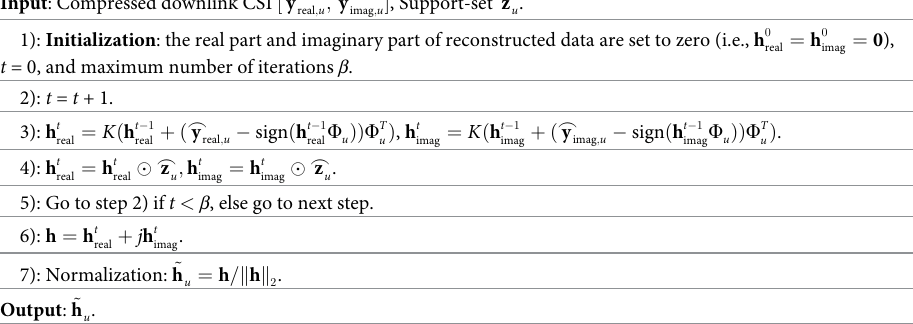
Table 4. Initial feature extraction